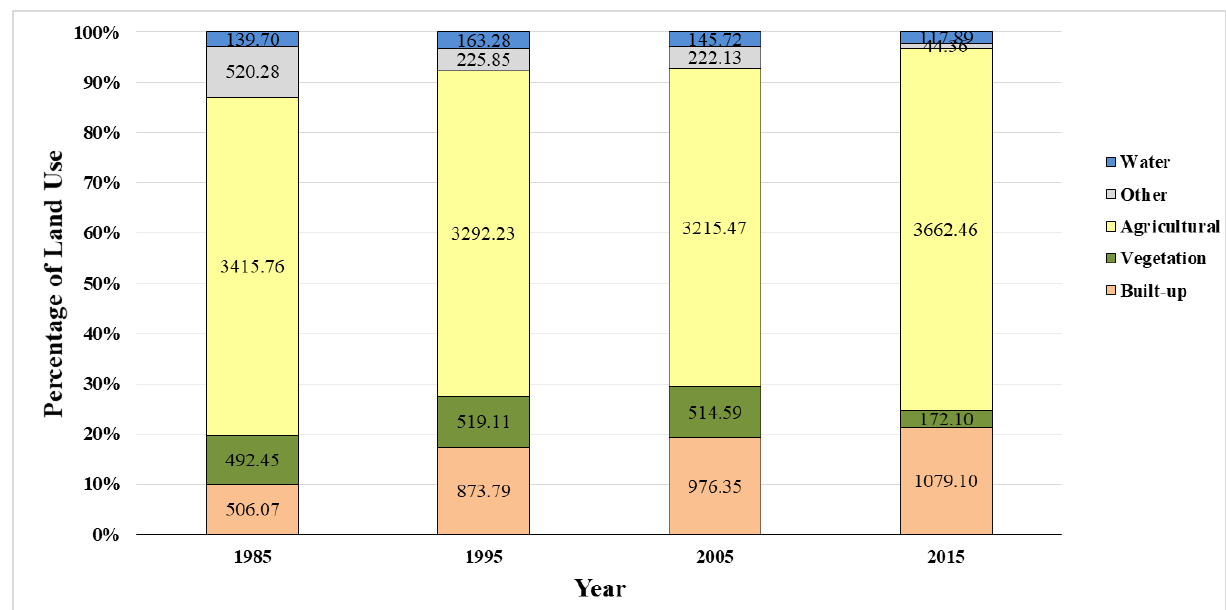
Figure 3. Cumulative land use change in study area of 11 smart cities of Uttar Pradesh (Numbers within bars depict the area in km 2